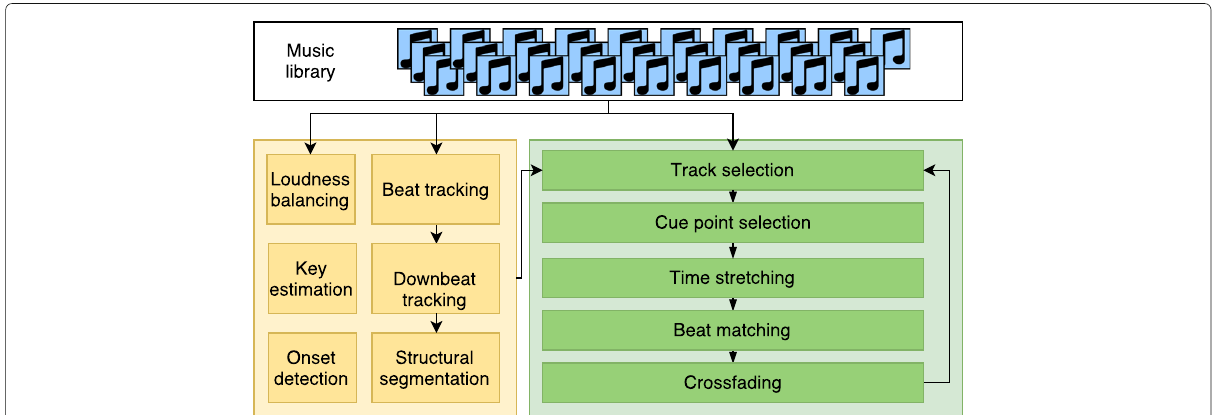
Fig. 8 Automatic DJ system architecture. On the left, in yellow, are the annotation submodules. On the right, in green, are the modules used “live” during the mixing process